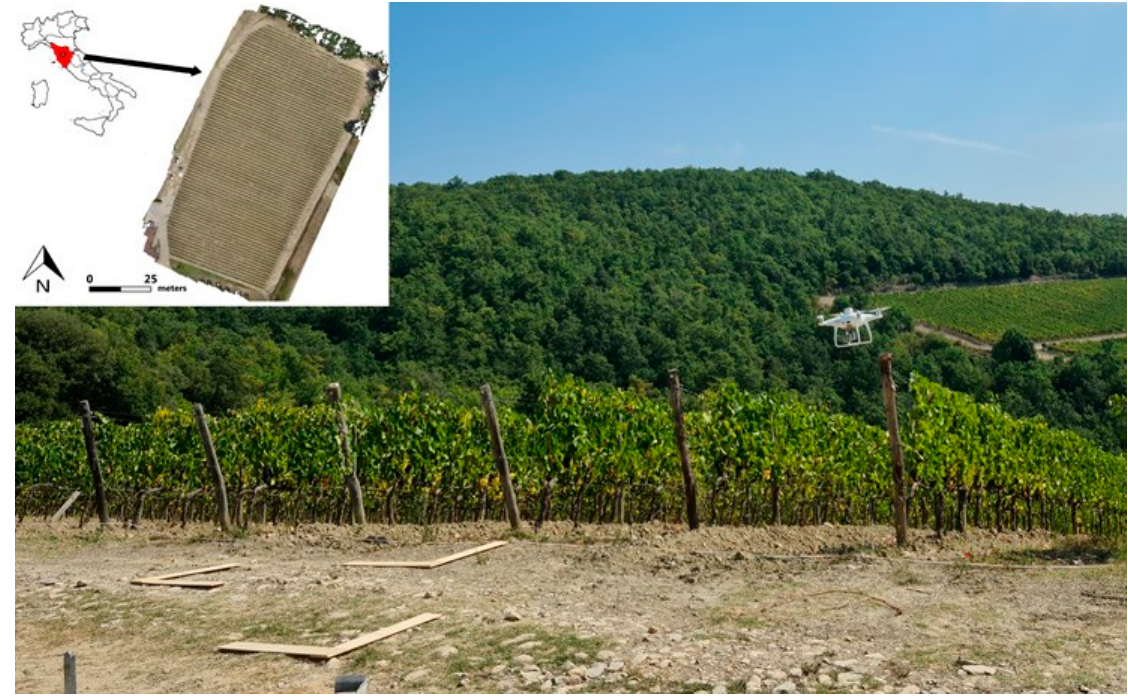
Figure 1. Study vineyard located in Tuscany,